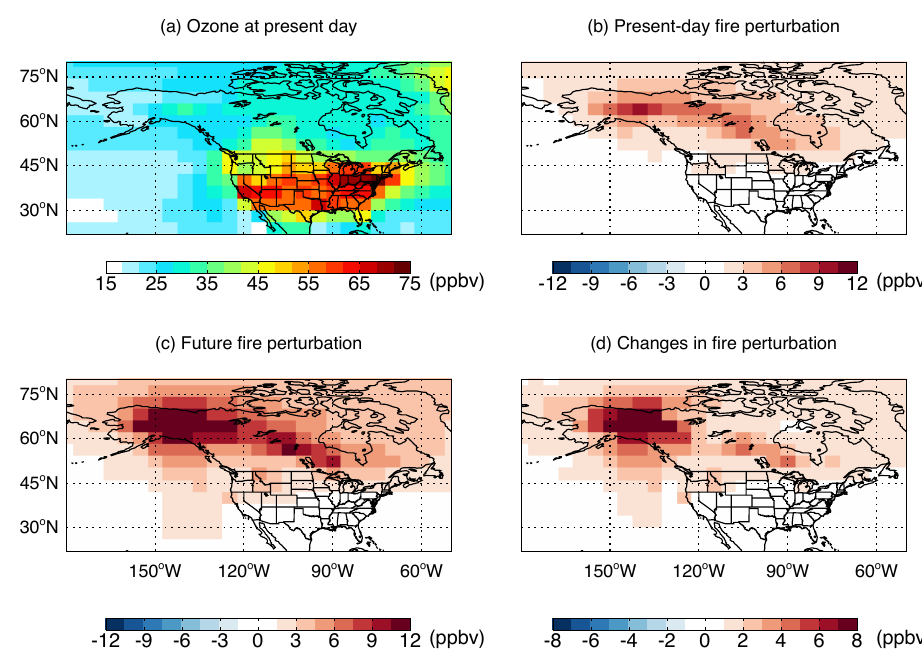
Figure 9. (a) Simulated present-day MDA8 ozone at the surface in summer (June–August). (b) shows the contribution to MDA8 summertime ozone by wildfire emissions in the present day (FULL_PD – NOFIRE_PD), and (c) shows the same contribution, but at the mid-century (FULL_A1B – NOFIRE_A1B). (d) presents the change in the contribution of wildfires to MDA8 ozone between the two periods (i.e., c–b ). Descriptions of the sensitivity simulations are given in Table 1. The color scale saturates at both